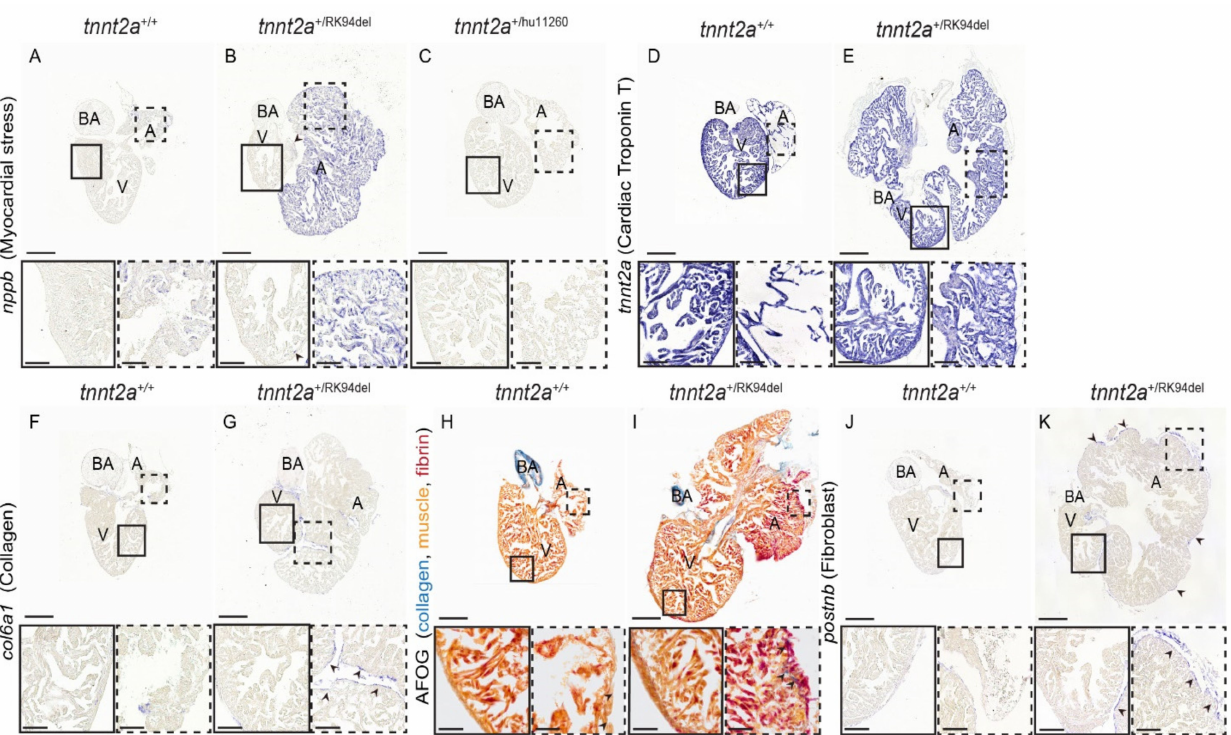
Figure 3. Hearts of adult tnnt2a +/RK94del display increased myocardial stress and fibrosis. ( A – C ) In situ hybridization on 4-month-old adult heart sections of tnnt2a +/+ , tnnt2a +/RK94del , and tnnt2a +/hu11260 stained for nppb , a marker of myocardial stress. In situ hybridization on adult heart sections of tnnt2a +/+ and tnnt2a +/RK94del stained for ( D , E ) tnnt2a , to mark cardiac Troponin T expression, and ( F , G ) col6a1 , which marks collagen. ( H , I ) AFOG staining, which marks collagen in blue, muscle in orange, and fibrin in red of tnnt2a +/+ and tnnt2a +/RK94del . ( J , K ) In situ hybridization on adult heart sections of tnnt2a +/+ and tnnt2a +/RK94del stained for postnb , to mark fibroblasts. Images were taken at a magnification of 20 × , except for ( H , I ) where magnification was at 60 × . Scale bars are 200 µ m for whole-heart tile scans, 50 µ m for zoom-in regions, and 20 µ m for zoom-in regions of H, I. A: atrium, V: ventricle, BA: bulbus